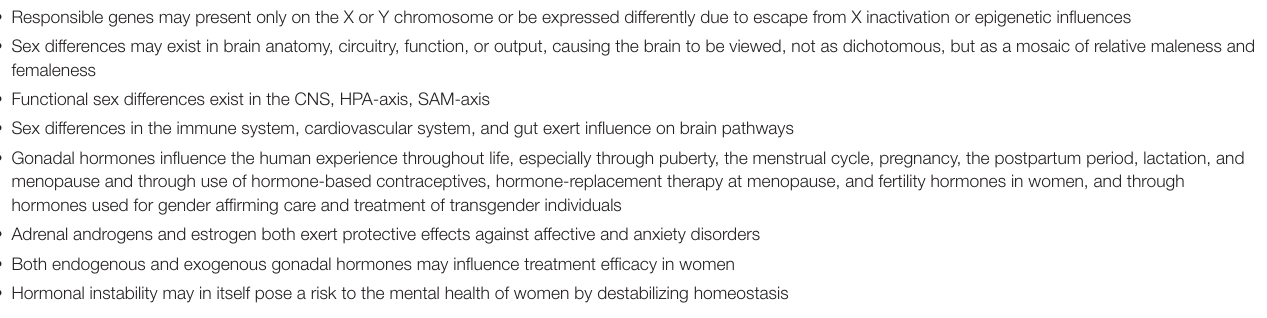
TABLE 2 | Summary of sex-based theories.